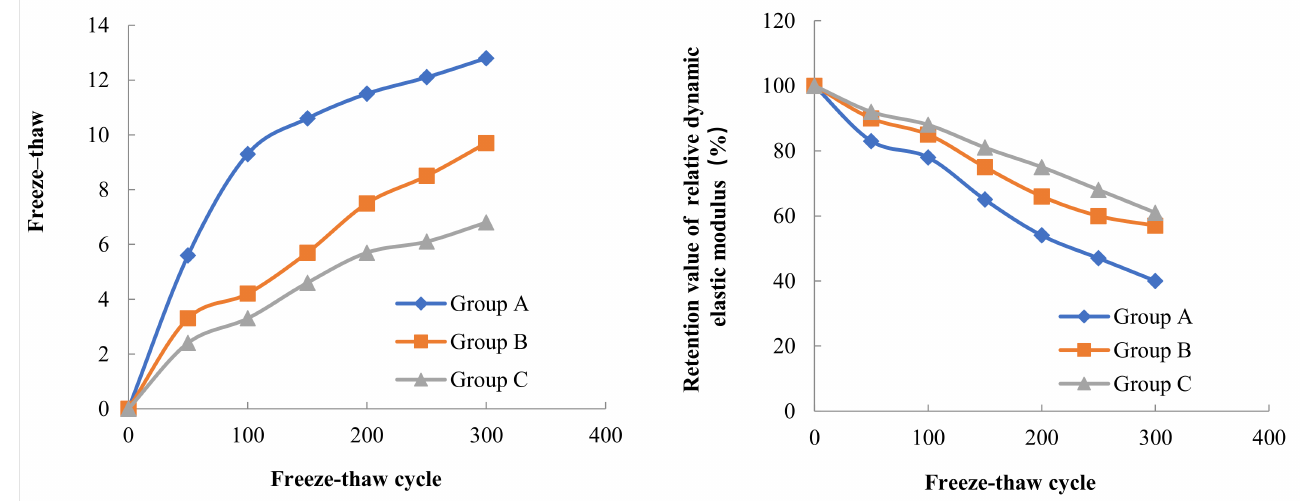
Figure 4. Frost resistance of concrete with different internal humidity ( − 40 ◦ C freezing temperature).